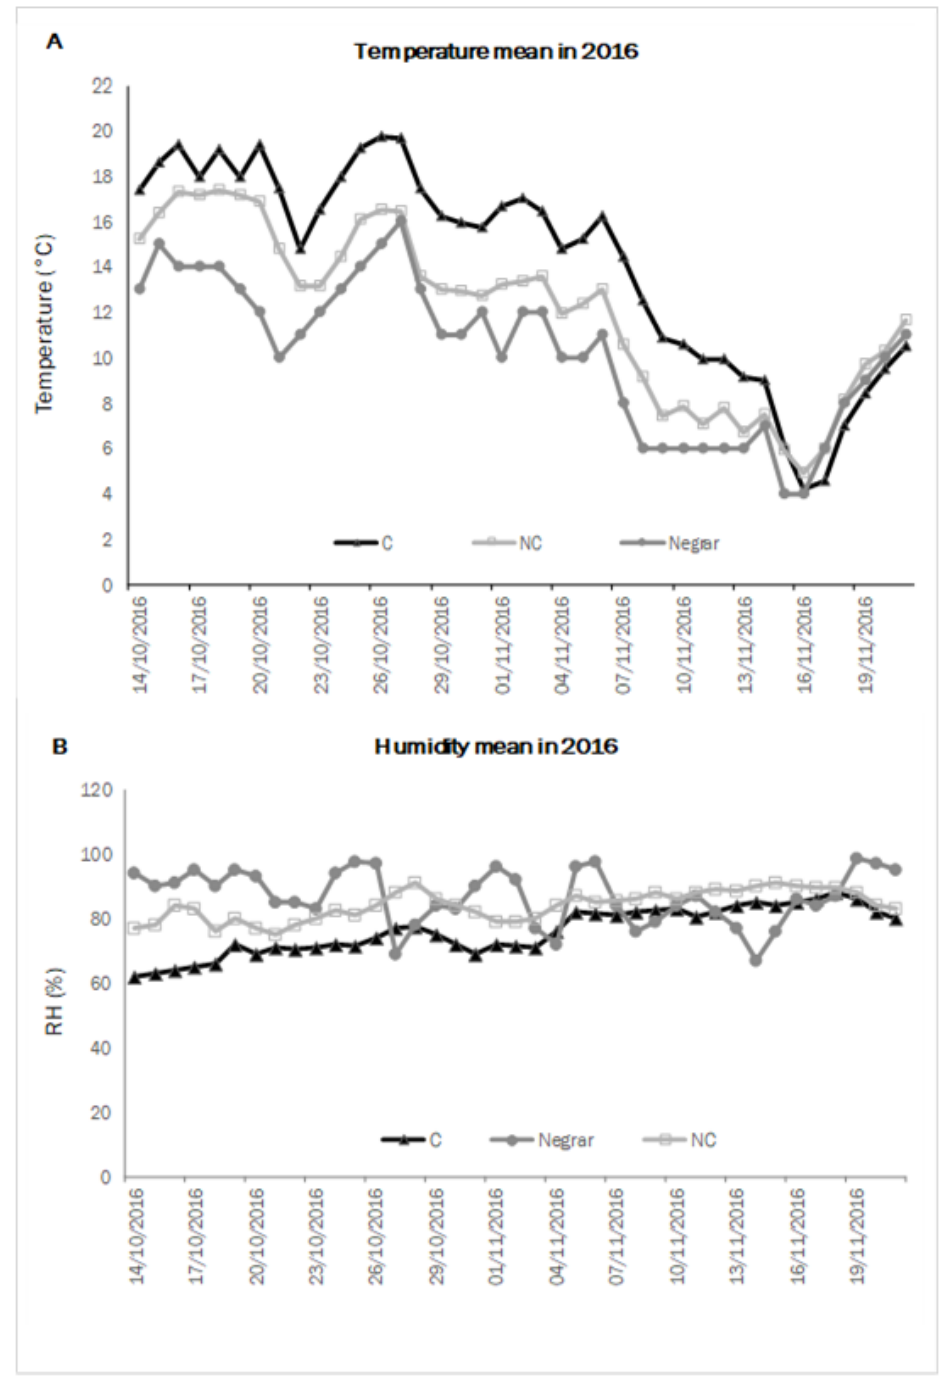
Figure 1. Daily mean air temperature ( A ) and humidity ( B ) in controlled (C) and not-controlled (NC) chambers and outside environment (Negrar) in 2016.